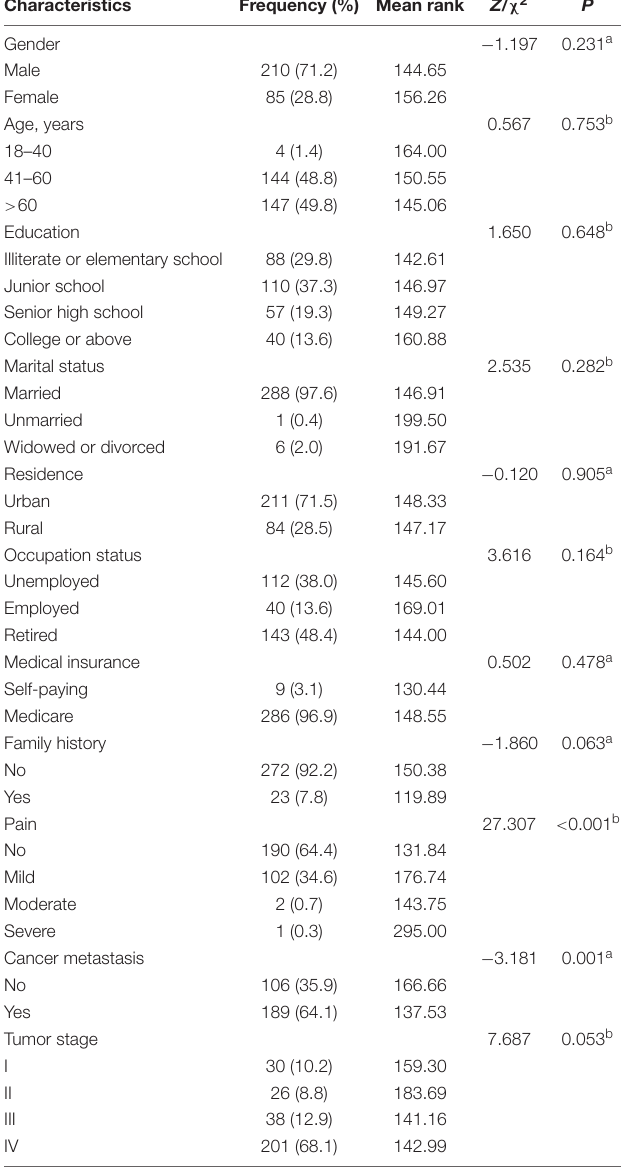
TABLE 1 | Psychological distress among patients with different sample characteristics ( N =